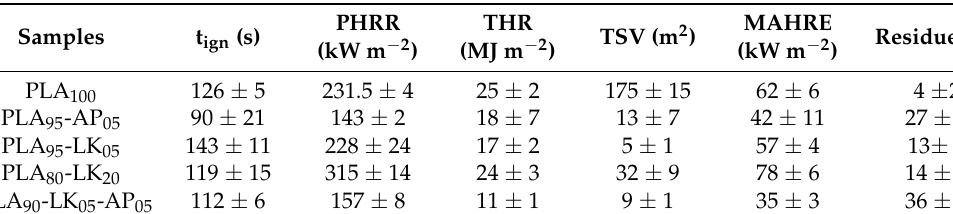
Table 7. Results of cone calorimeter test for the knitted fabrics (25 kW m − 2 ).